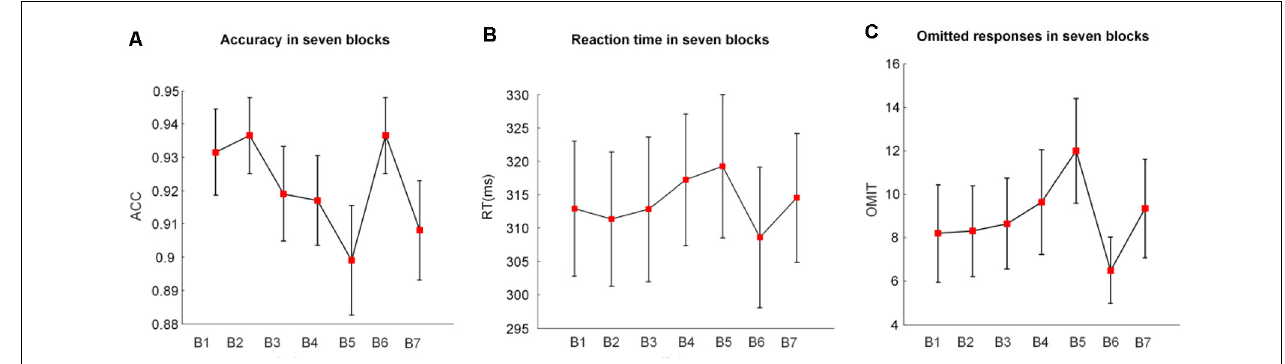
FIGURE 3 | (A) The P300 waveforms (left) averaged from electrodes of FC1, FC2, FCz, C1, C2, Cz, CP1, and CP2, the topographies (middle) in the four conditions, and P300 waveforms coalesced for the reward vs. non-reward states (right). (B) Mean values and standard error of the P300 amplitude in the four conditions (left) and in the two main factors (right). HighV (high vigilance blocks) = (NRHV + RHV)/2, LowV (low vigilance blocks) = (NRLV + RLV)/2, NReward (no-reward blocks) = (NRHV + NRLV)/2, and reward (reward blocks) = (RHV + RLV)/2. Analysis of variance (ANOVA) results were marked by ∗ p < 0.05 and ∗∗ p < 0.01.